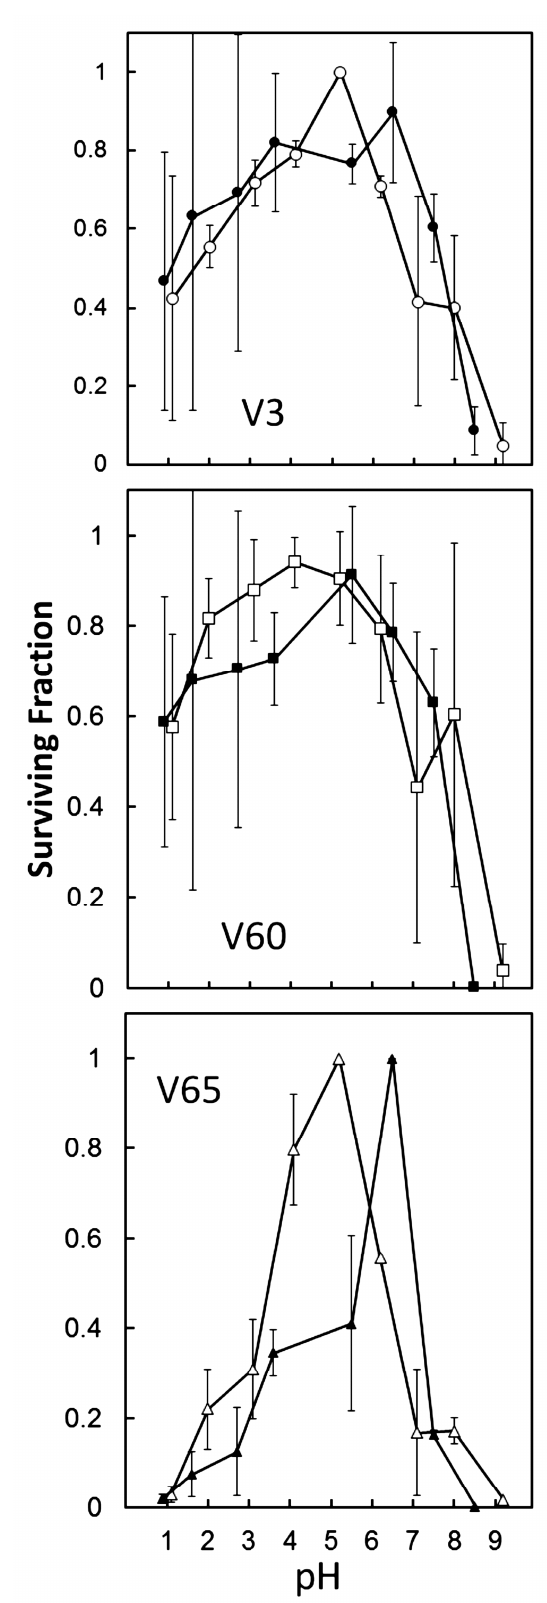
Figure 6. Virion stability as a function of pH. Virus suspensions were diluted in various pH buffers and incubated 70 ◦ C for one hour. For each virus, the two lines (solid vs. open symbols) represent different series of buffers covering similar pH ranges (see Section